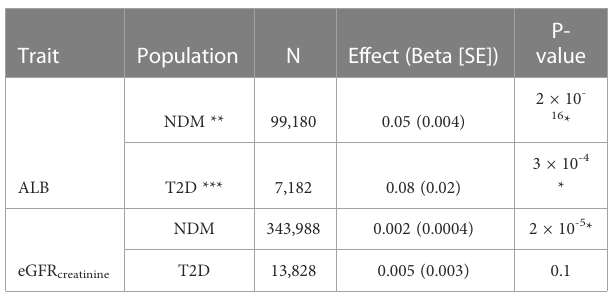
Mellitus;*Statisticallysigni fi cant(P<0.05).**outoftotal107,276individualswithcontinuous urinary albumin levels. Albuminuria-SNV interaction was only tested when primary SNV-